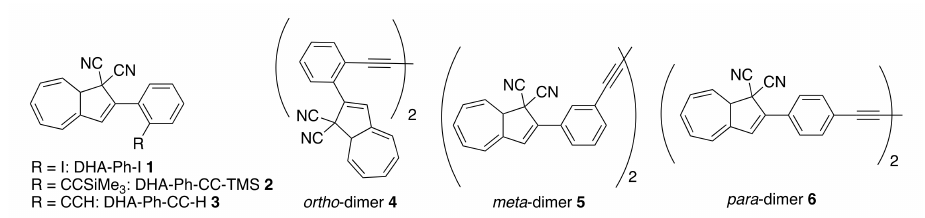
Figure 3. ortho -Phenyl-substituted DHAs and ortho -, meta - and para -linked DHA